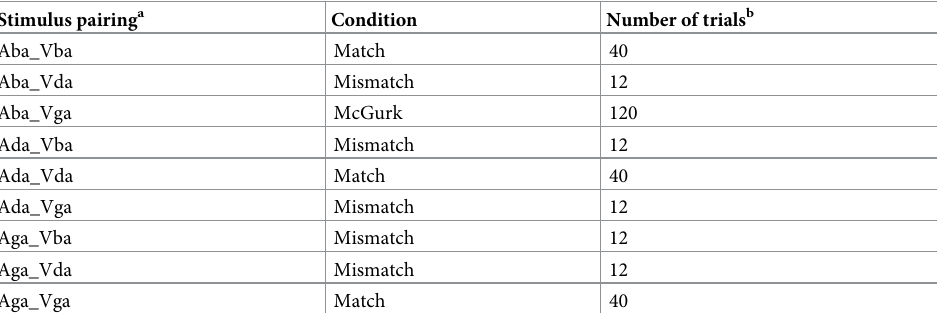
a Stimulus names represent the auditory and visual portions of each pairing (e.g., Aba_Vga corresponds to audio “ba” paired with visual “ga”). b Stimuli were recorded from two different speakers, with each speaker’s tokens comprising half of the trials presented for each audiovisual